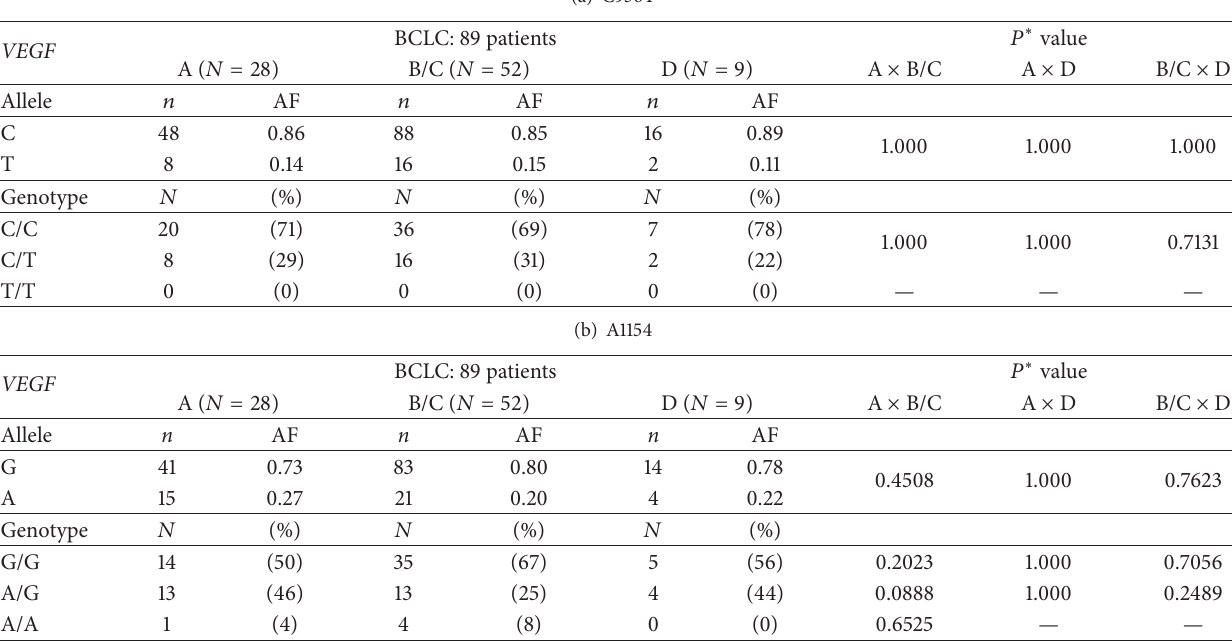
∗ Fisher’s exact test or Chi-Square test with Yates correction; BCLC = Barcelona Clinic Liver Cancer; VEGF = vascular endothelial growth factor; 𝑁 = number of subjects; 𝑛 = number of alleles; AF = absolute frequency.